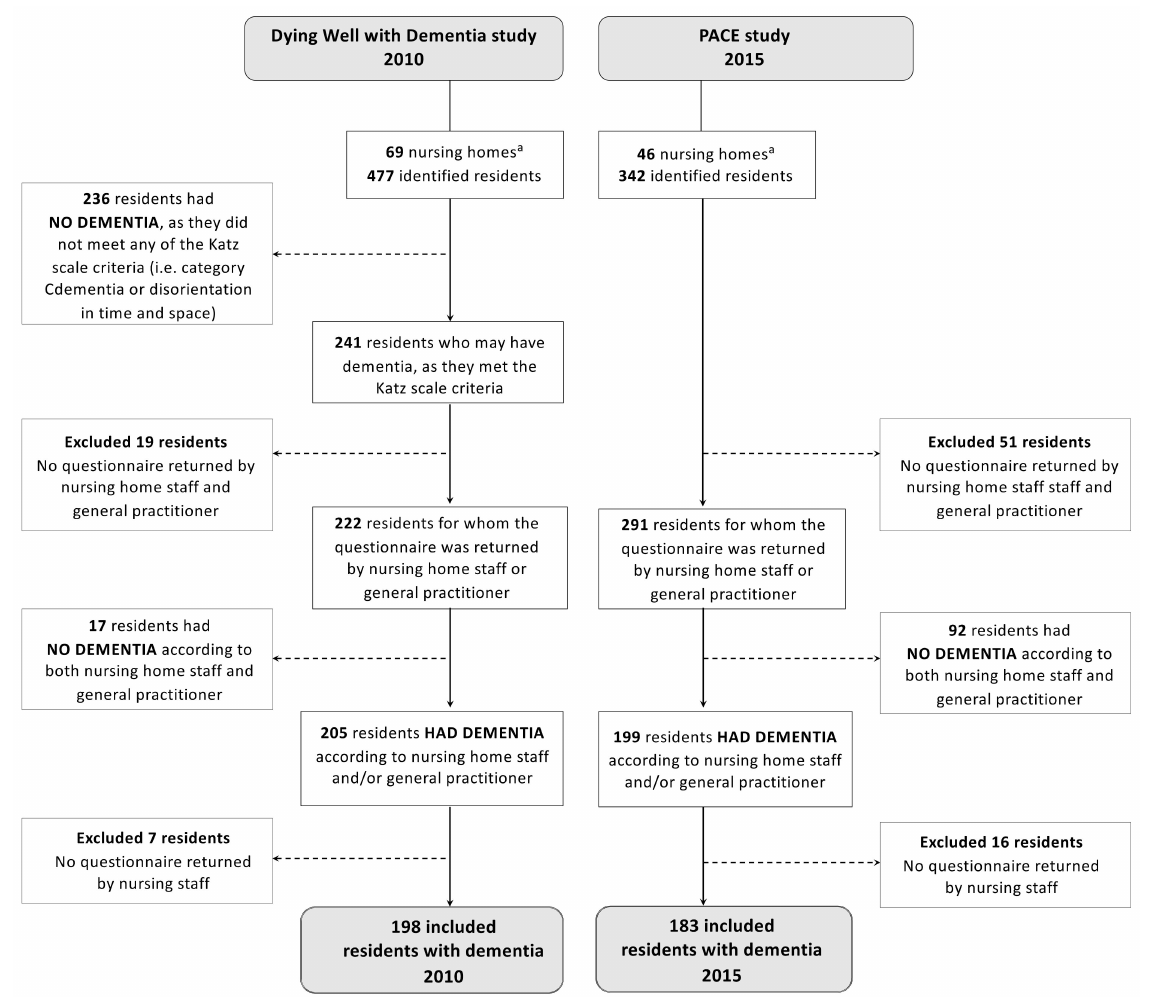
Figure 1. Overview of the identification of residents with dementia in 2010 and 2015. a Because we excluded a number of residents from the total sample, the final number of nursing homes were 64 in 2010 and 43 in 2015. In 2010, 205 residents had dementia (numerator) of the 477 identified residents. In 2015, 199 residents had dementia (numerator) of the 342 identified residents